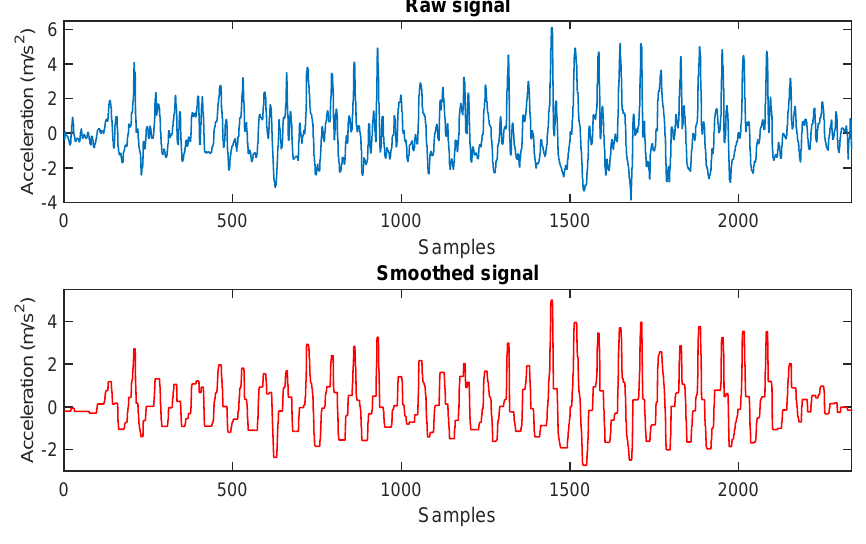
Figure 3. Smoothing of Z -axis